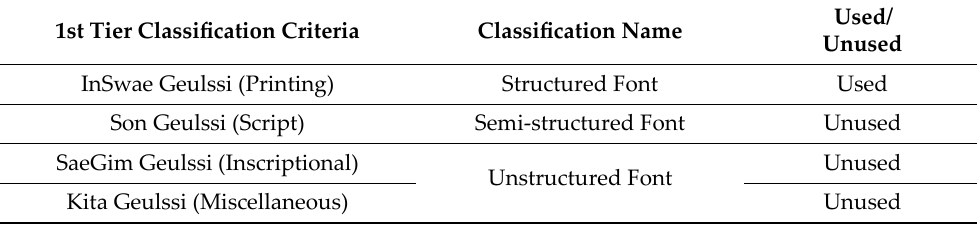
Table 2. Whether to use font by classification based on Korean font shape classification standards (TTA) in previous study.